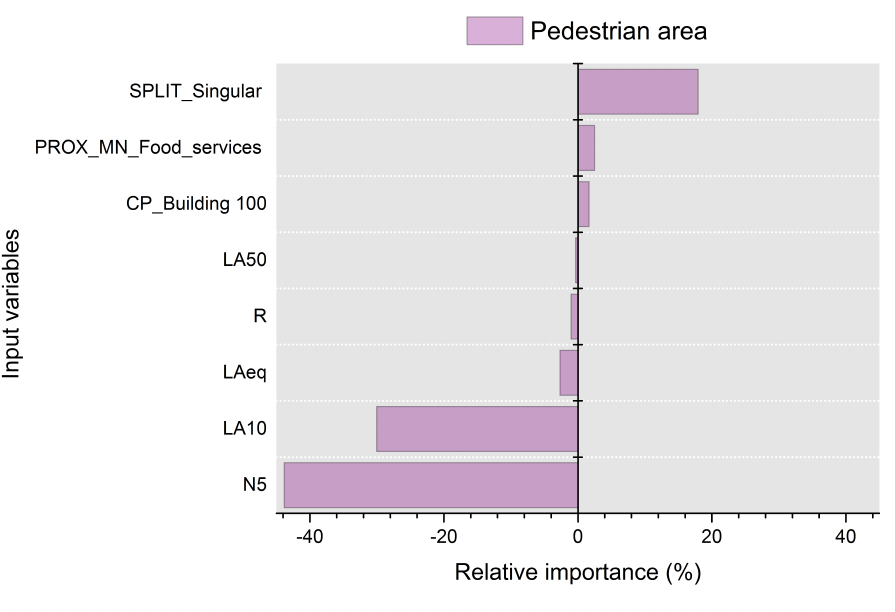
Figure 11. Percentage of relative importance of the predictors on the results calculated with the Olden et al. method for the pedestrian areas. Values higher than zero mean a positive relative effect, and lower than zero, a negative relative effect. The variables selected were spatial metric “split” calculated for the land use “singular buildings” (SPLIT_Singular), spatial metric “proximity” calculated for the land use “food services” (PROX_MN_Food), “percentage of generic buildings in the aerial photograph within a distance of 100 m” (CP_Building_100), sound pressure level exceeded 50% of time (LA50), roughness (R), and A-weighted equivalent sound pressure level (LAeq), sound pressure level exceeded 10% of time and loudness